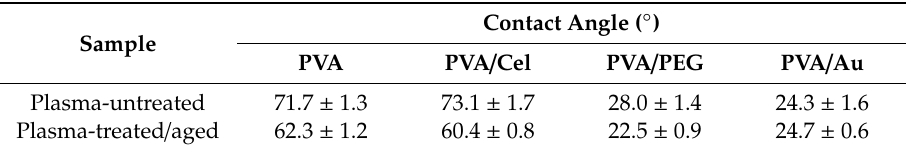
Table 1. Values of the contact angles of PVA foils non-treated or treated with plasma and aged for 30 days. The foils were either non-doped (PVA) or were doped with cellulose (PVA/Cel), with poly(ethylene glycol) (PVA/PEG) or with Au nanoparticles in a PEG colloid solution (PVA/Au).